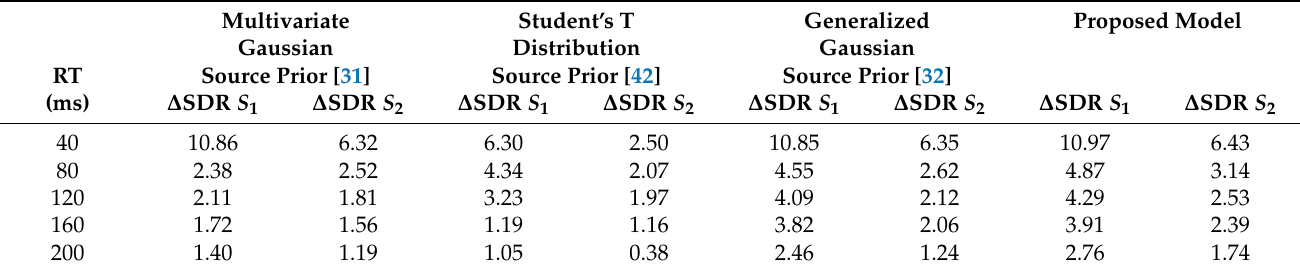
Table 4. Average RT results for the second proposed model shown in Figure 2 with variable RT for multistage BSS models having different source